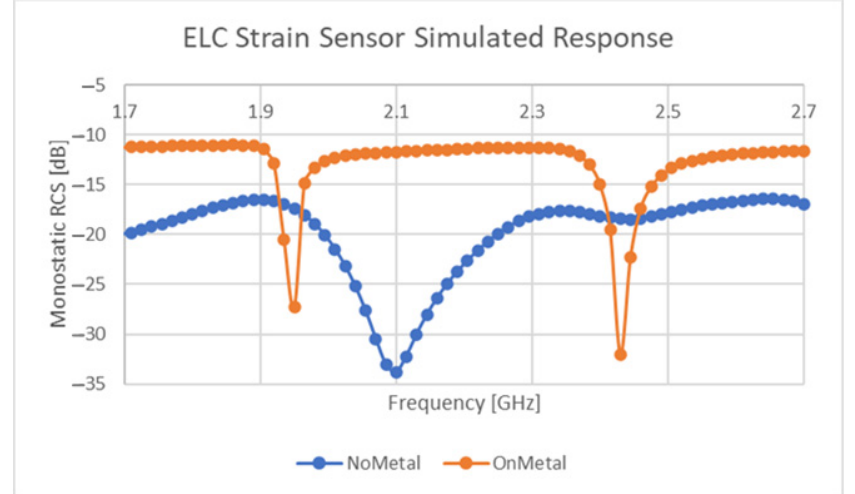
Figure 12. Simulated sensor response.